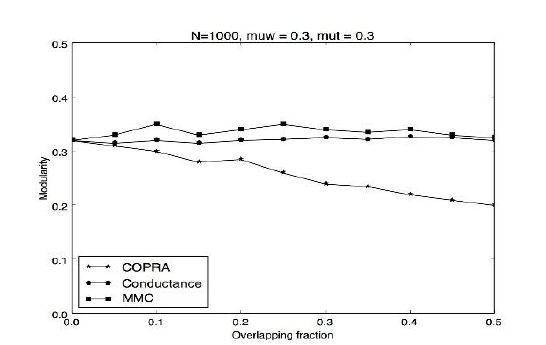
Figure 4. Modularity of the community structure detected by COPRA, Conductance and MMC while N= 1000 and muw=mut =0.3.